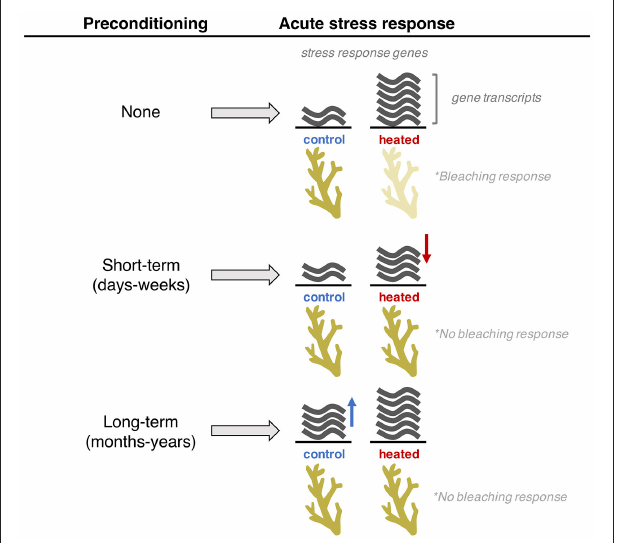
FIGURE 5 | Pathways of acclimatization to elevated temperatures. Short-term preconditioning results in the reduced expression of stress response genes during acute heat stress. Long-term preconditioning results in a fundamental shift in baseline expression of stress response genes